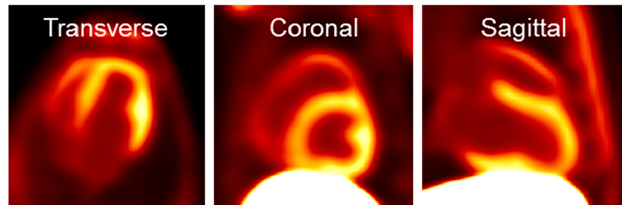
Figure 3. Representative [ 18 F]DHMT PET images of the heart in a beagle dog.